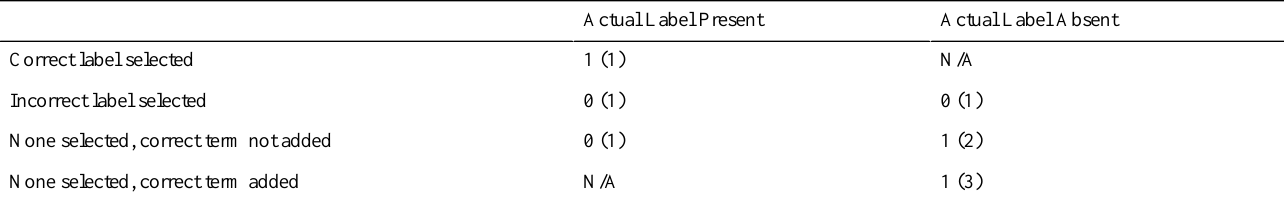
Table 1. Scoring scheme for the label-linking test (weights are in